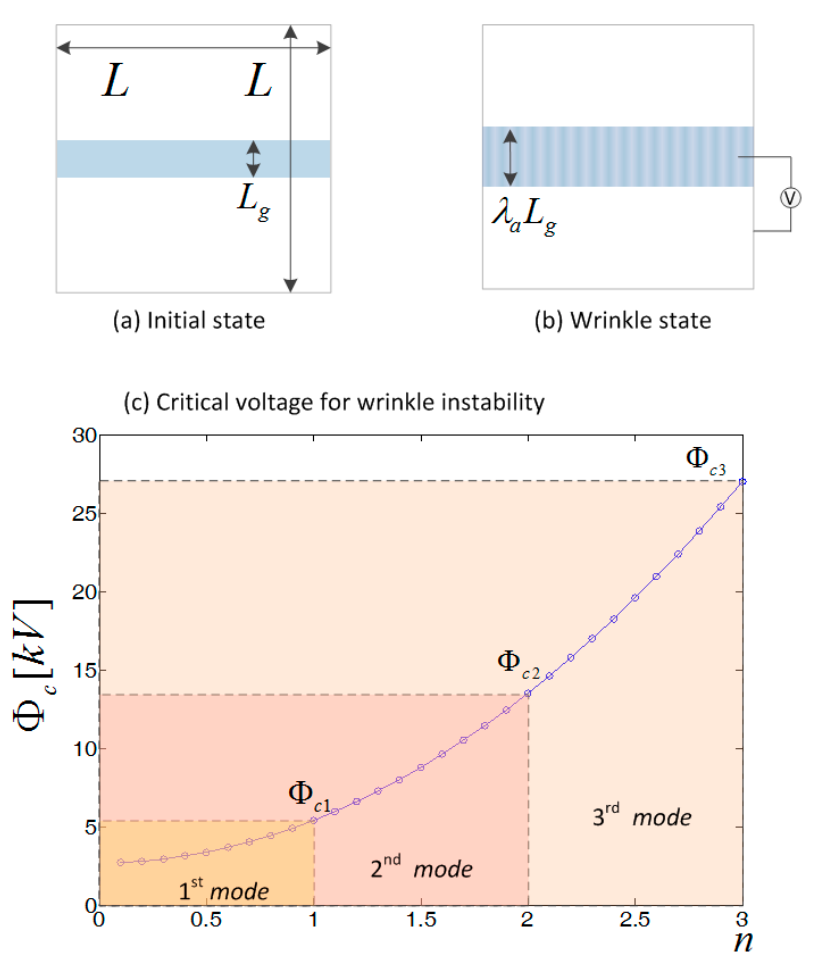
Figure 9. ( a ) The initial state of the hydrogel and dielectric elastomer; ( b ) the wrinkled state in actuation; ( c ) the critical voltage at different order mode of wrinkling instability, where n = 1, 2, 3.